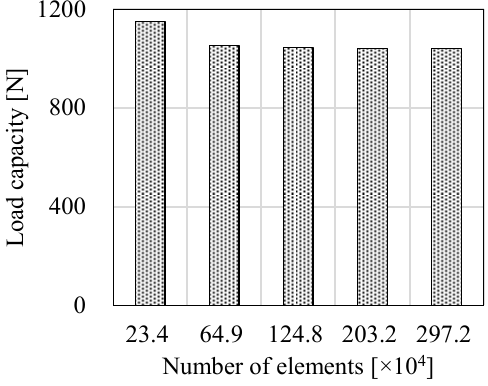
Figure 5. Grid sensitivity analysis.